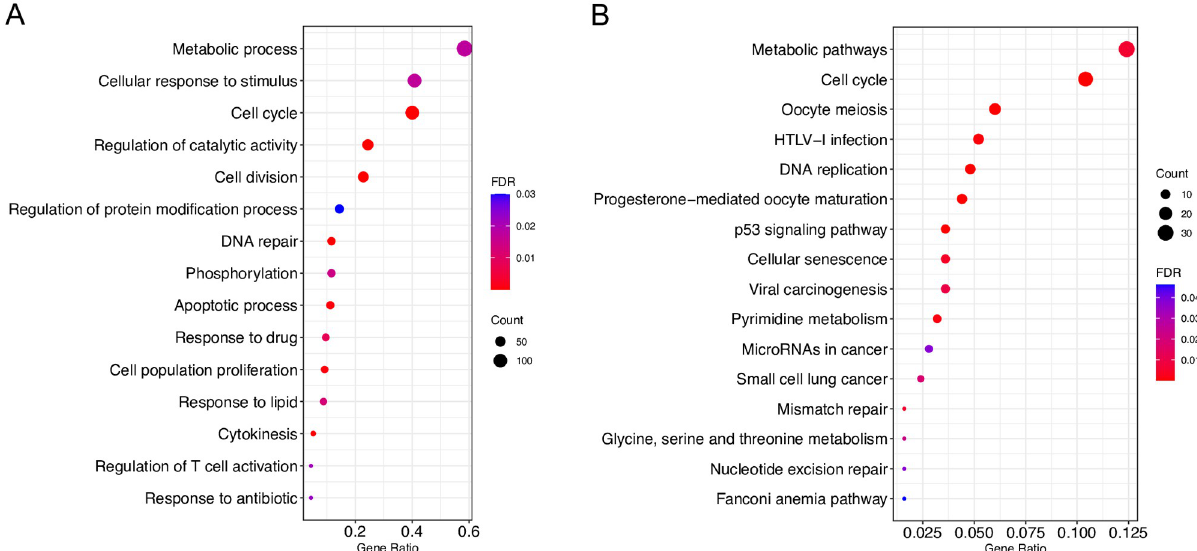
Fig 4. GO and KEGG pathway enrichment analysis for human red module genes. (A) Selected key biological processes. (B) All enriched KEGG pathways. GO terms and KEGG pathway remain when the FDR is < 0.05.